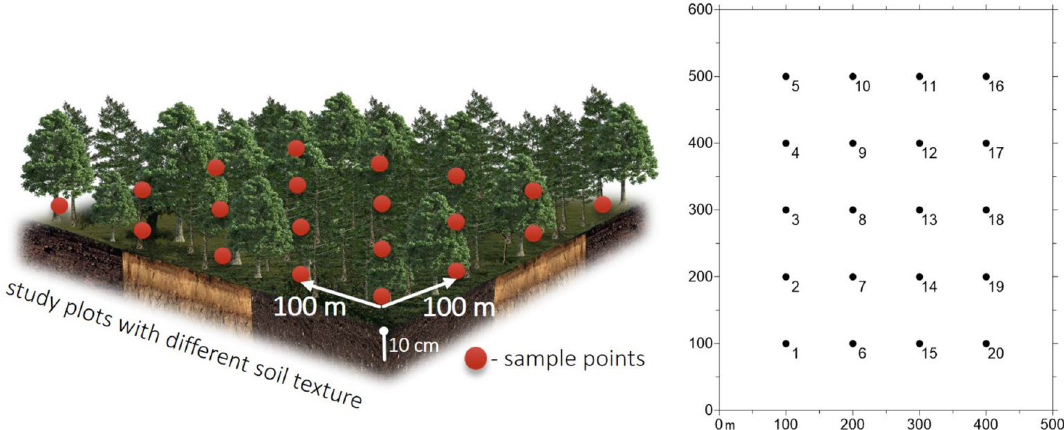
Figure 2. Scheme of the sampling points locations. GIMP 2.10.20 (https:// www. gimp. org), Surfer 10 software and elements from the Freepik website (https:// www. freep ik. com) were used to create the structure of the figure.